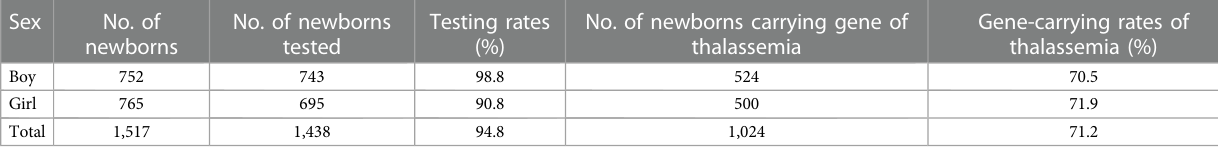
TABLE 1 The numbers of newborns and gene-carrying rates of thalassemia of newborns in Li people from January 2020 to April 2021 in the Hainan Li autonomous region. Sex No. of